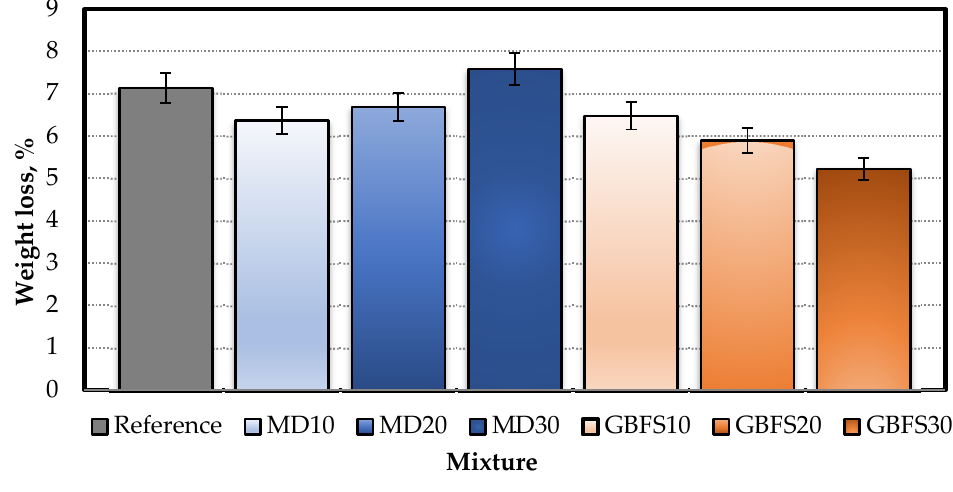
Figure 7. Bohme abrasion test results.